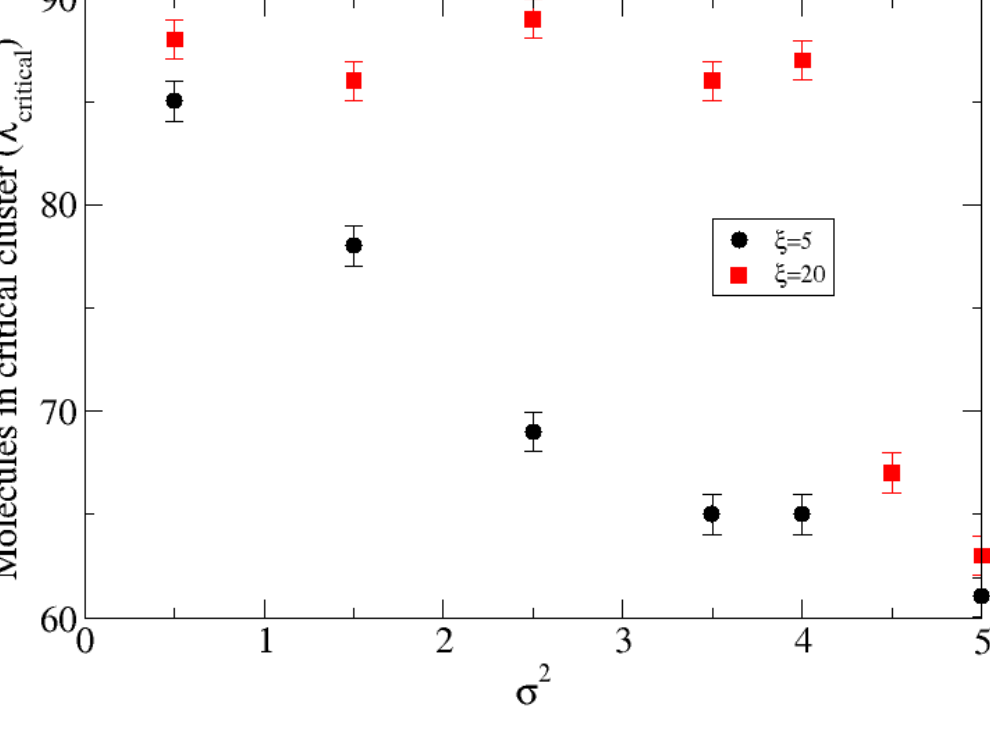
Figure 3. Number of molecules in the critical cluster as a function of roughness, σ , for correlation lengths ξ = 5 and 20 as determined from the